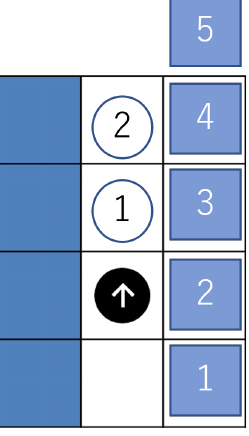
Figure 5. Ten types of relocation states with wall and agent combinations. The two circles are the positions of the two types of opponent agents and the five squares are the five types of the walls positions of narrow